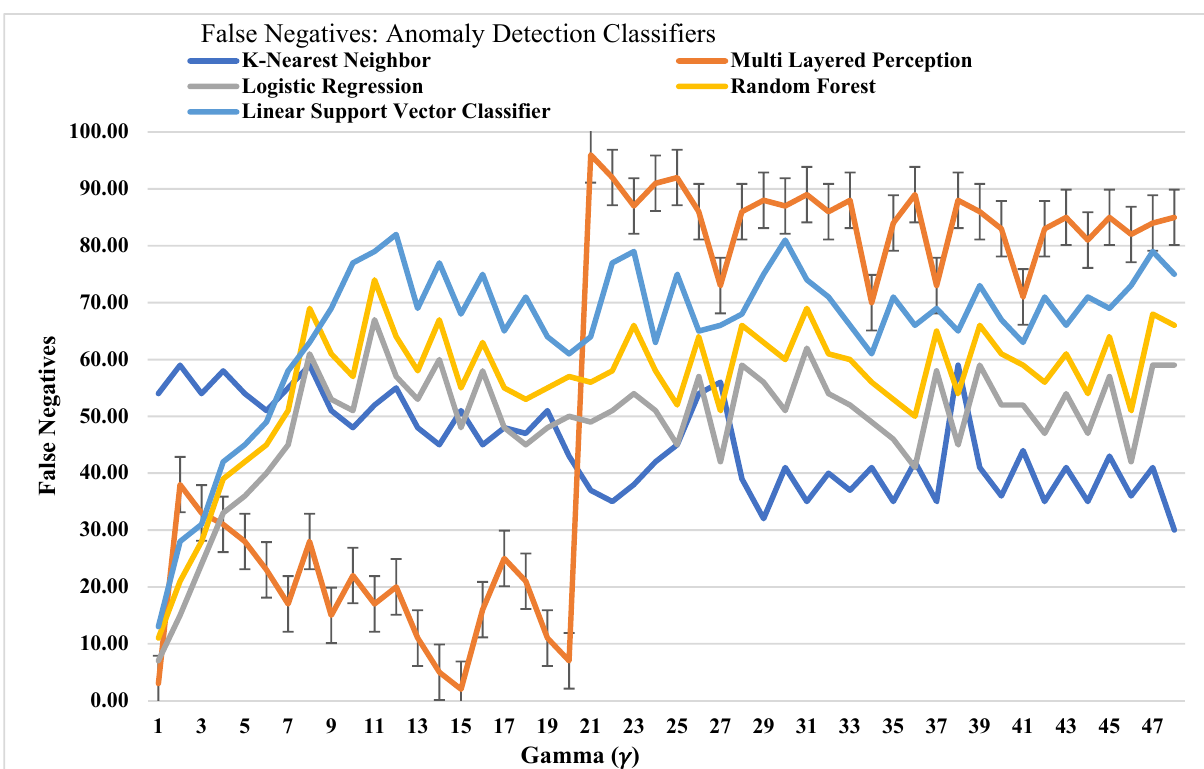
Figure 10. Different models with Accuracy and false negatives.